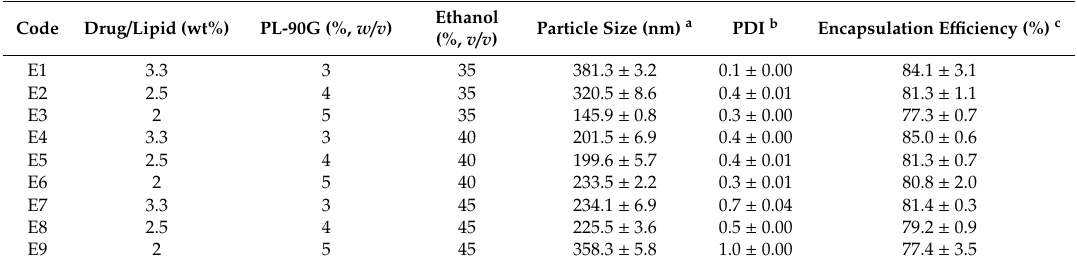
Table 2. Composition and properties of di ff erent anthralin ethosomal formulations. Code Drug / Lipid